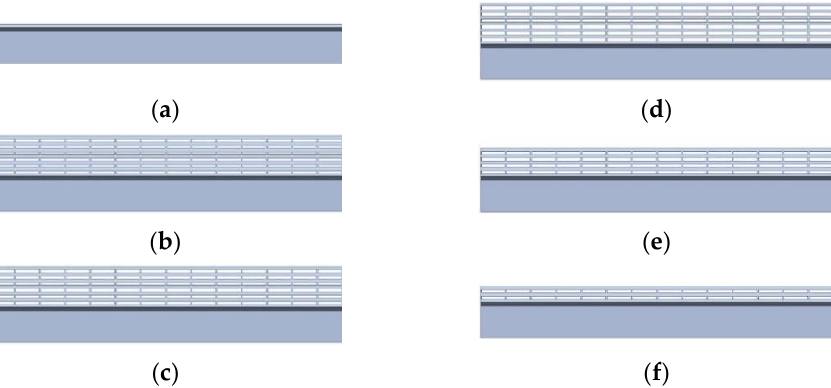
Figure 2. Geometric models of the bridge wind barrier (( a ) Bare bridge; ( b ) Scheme 1 of the wind barrier: the porosity is 40%, and the height is 3 m; ( c ) Scheme 2-1 of the wind barrier: the porosity is 50%, and the height is 3 m; ( d ) Scheme 3 of wind barrier: the porosity is 60%, and the height is 3 m; ( e ) Scheme 2-2 of wind barrier: the porosity is 50%, and the height is 2 m; ( f ) Scheme 2-3 of the wind barrier: the porosity is 50%, and the height is 1